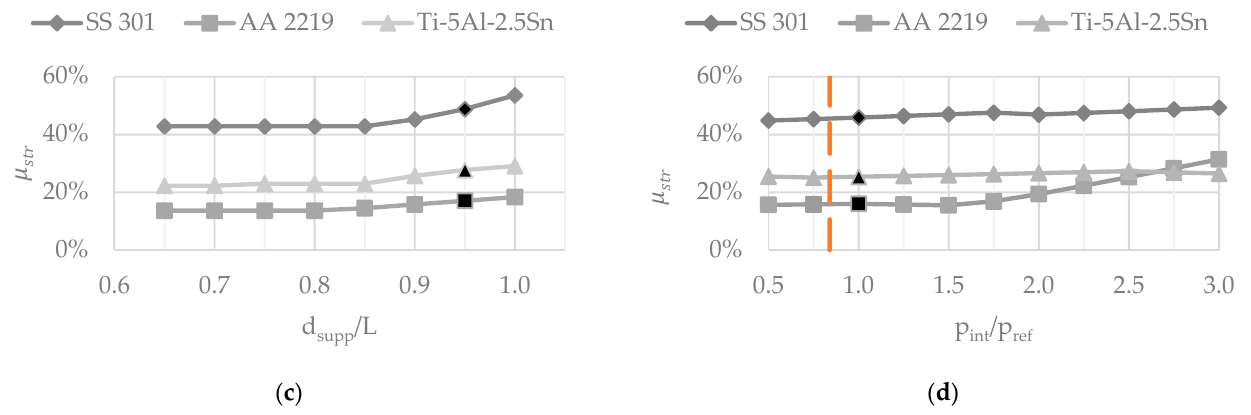
Figure 16. Structural mass fraction ( µ str ) for different materials and design parameters: ( a ) f end , ( b ) L / D str , ( c ) d supp / L , and ( d ) p int / p ref